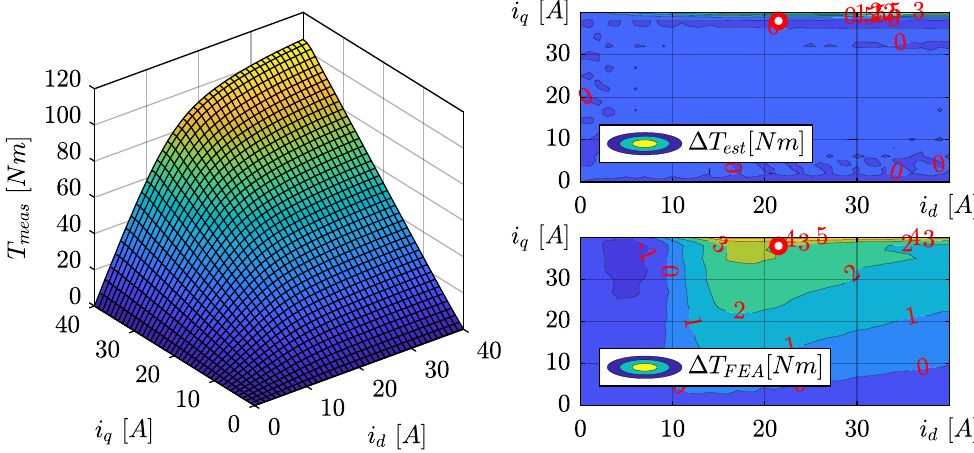
Figure 16. Measured torque map ( left ) and torque difference contours ( right ) for the TCICSM. The measured torque map comparison with the estimated torque by means of iden- tified flux linkages shows the maximum difference for ∆ T est is 3.264 Nm corresponding to the relative difference of 3.02 % with respect to the maximum measured torque. The comparison of the measured torque map with FE results shows a bigger mismatch with the maximum difference for ∆ T FEA is 5.54 Nm corresponding to the relative difference of 5.13%.